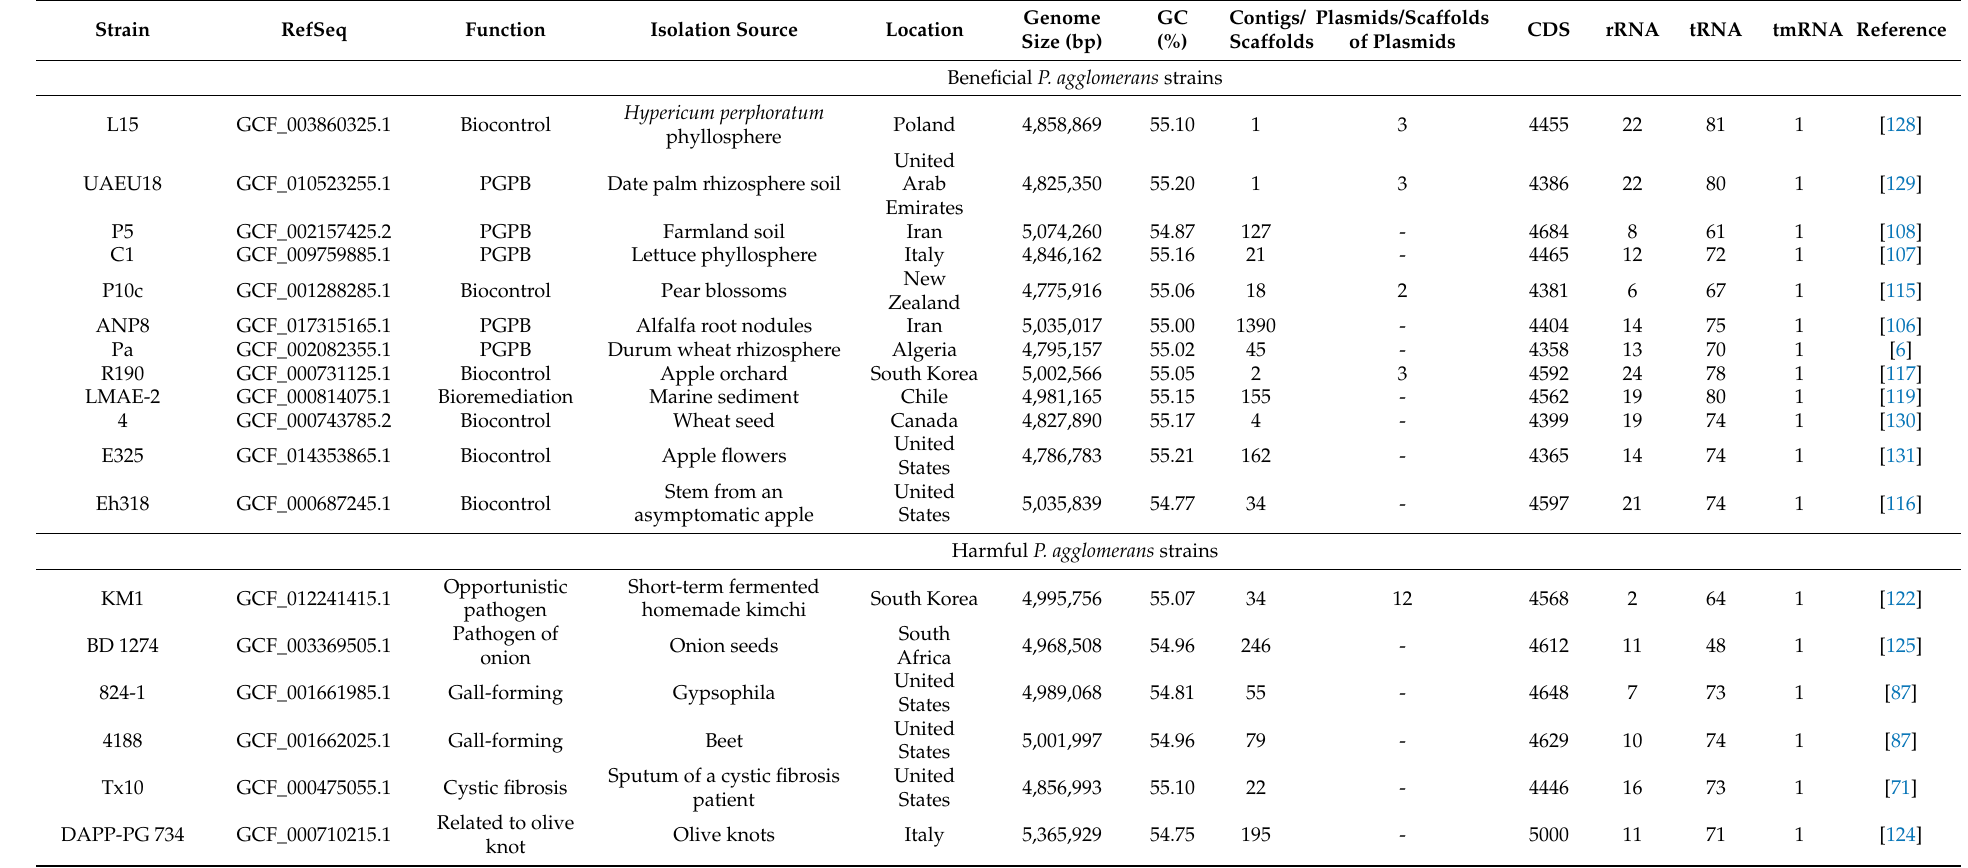
Table 1. Genomic data of Pantoea agglomerans strains with beneficial and harmful plant and environmental